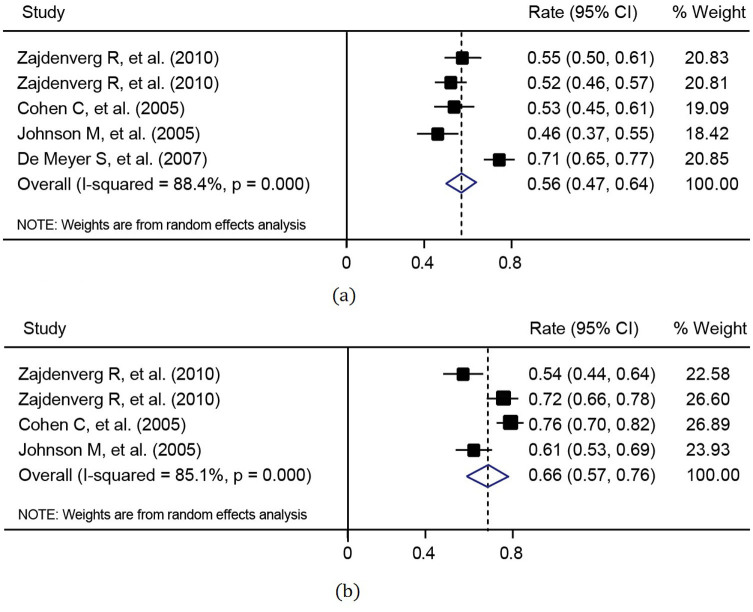
Meta-analysis of virologic response rates for treatment-experienced patients under (a) intention-to-treat analysis (heterogeneity: I2 = 88.4% and p < 0.001; publication bias: p = 0.086); and (b) pre-protocol analysis (heterogeneity: I2 = 85.1% and p < 0.001; publication bias: p = 0.089).